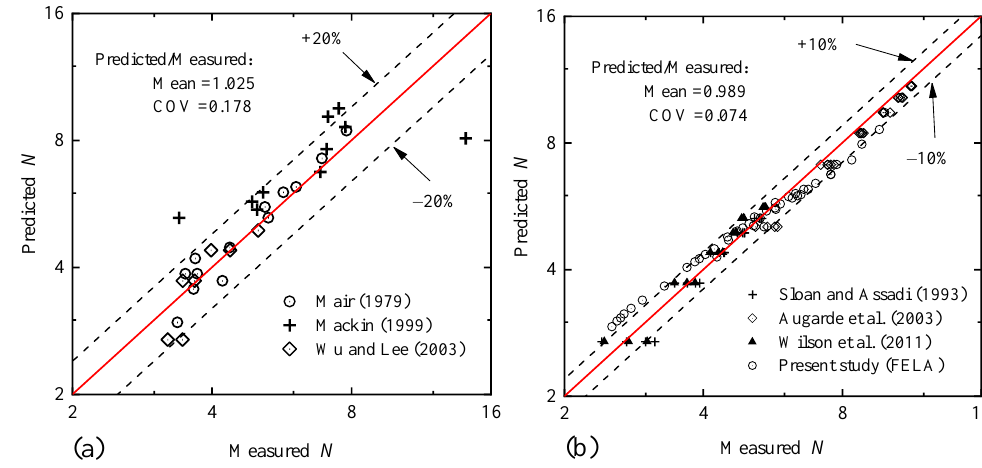
Figure 7. Measured versus predicted stability number: ( a ) model tests; ( b ) FELA results.